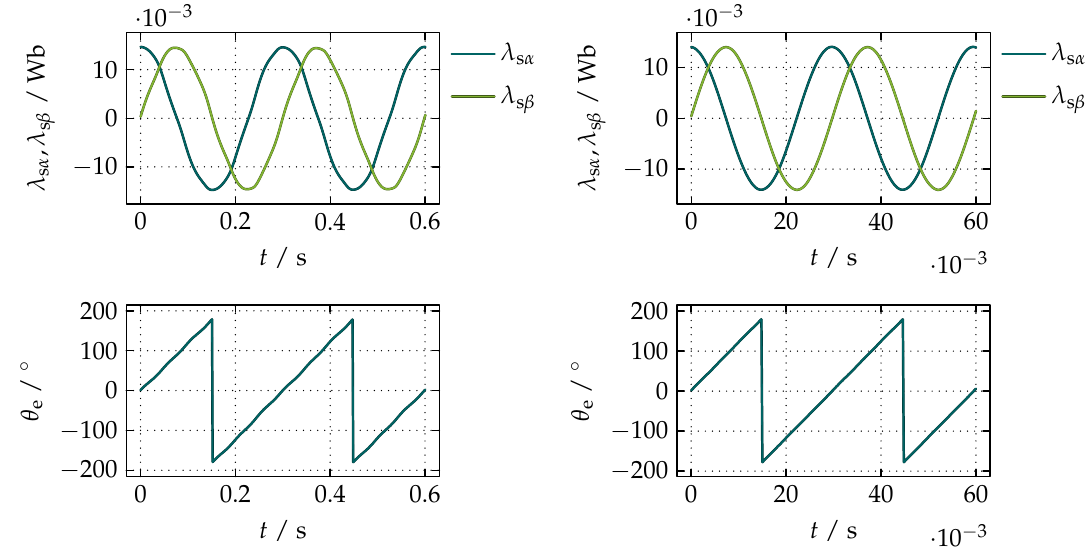
Figure 14. The unloaded motor at 100 rpm ( left ) and 1000 rpm ( right ) with the successful compensation of the integrational